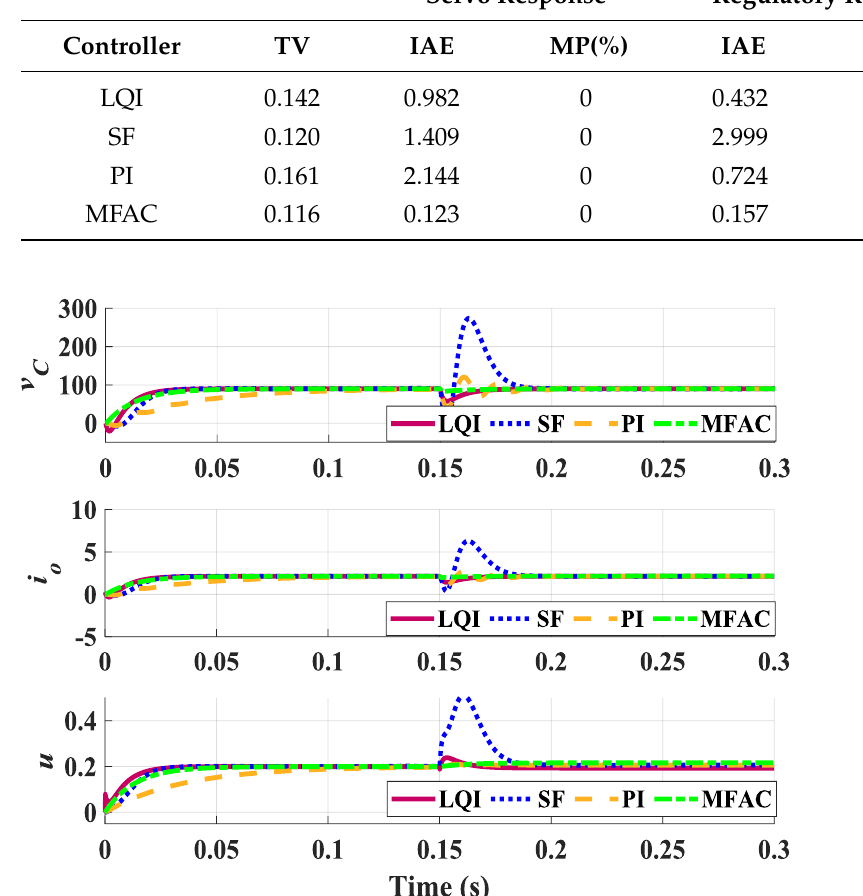
Figure 6. Perturbed closed-loop response for a 4 A load disturbance ( D = 0.4, R o =